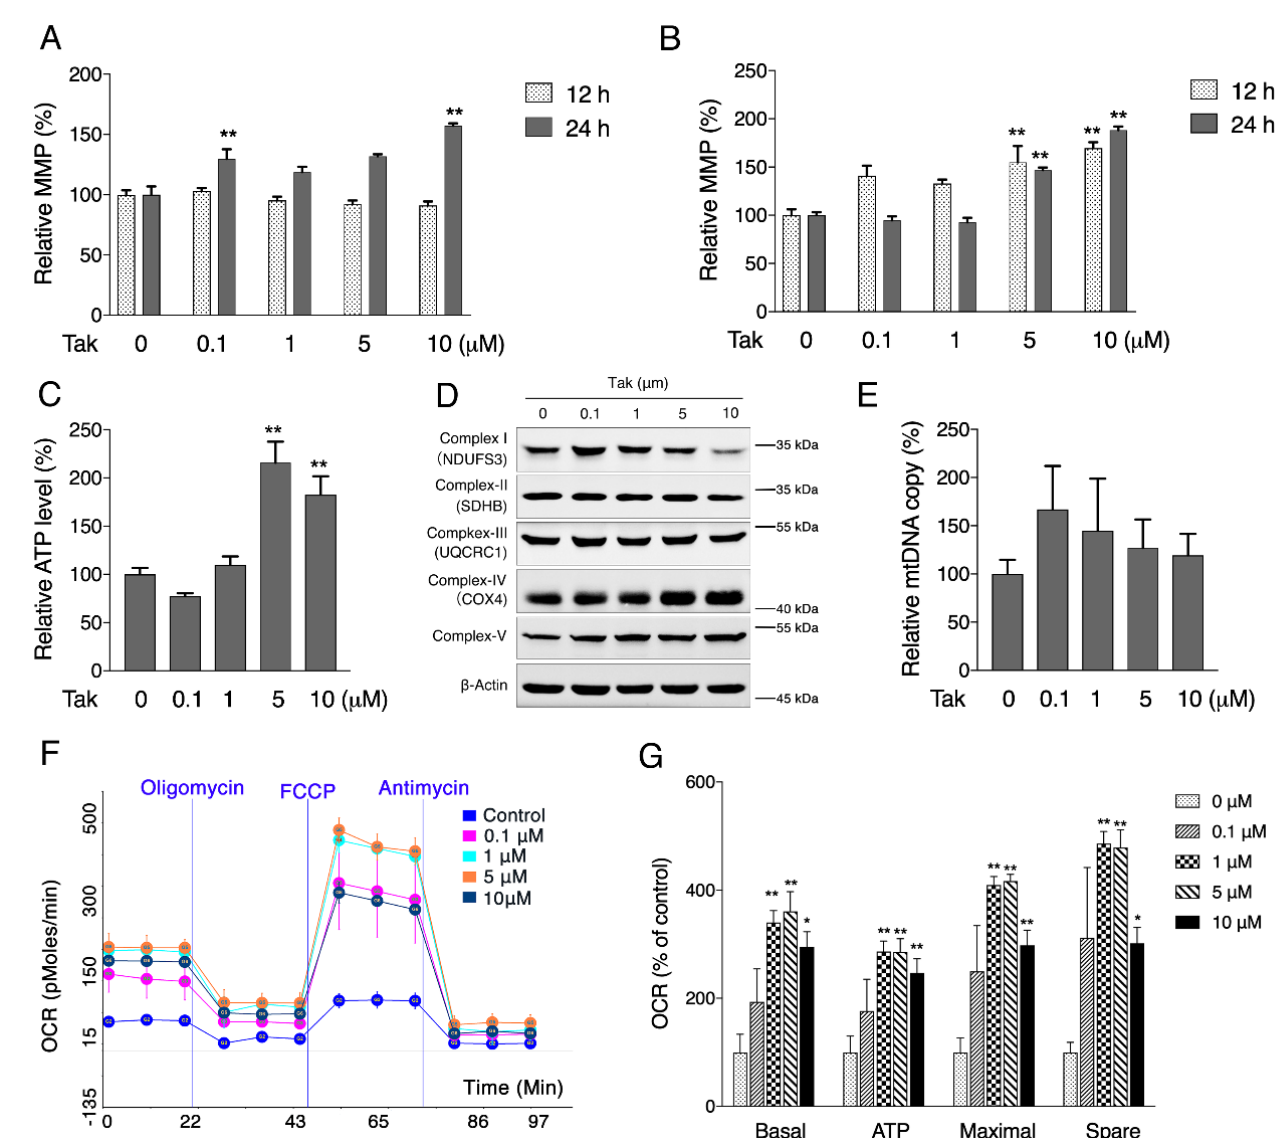
Figure 2. The effect of Tak on mitochondrial activities. ( A ) SH-SY5Y cells were treated with Tak at concentrations of 0, 0.1, 1, 5, and 10 μM for 12 and 24 h, and the MMP was assessed by JC-1 staining. ( B ) HT22 cells were treated with Tak at concentrations of 0, 0.1, 1, 5, and 10 µ M for 12 and 24 h, and the MMP was assessed by JC-1 staining. HT22 cells were treated with Tak for 24 h, and the cellular ATP level ( C ), mitochondrial complex subunit expression ( D ), mtDNA copy number ( E ), and mitochondrial oxygen consumption rate (( F ): experimental program; ( G ): statistical analysis) were analyzed. The values are presented as the mean ± S.E.M. from at least three independent experiments. * p < 0.05 and ** p < 0.01 vs. the control.